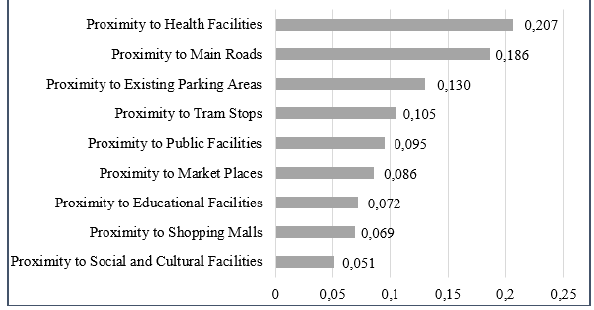
Figure 12. Weights of